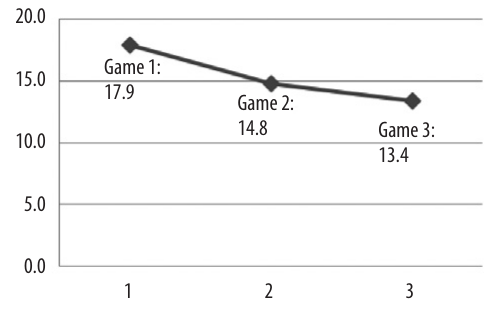
Fig 1. Average of negotiation stages in each